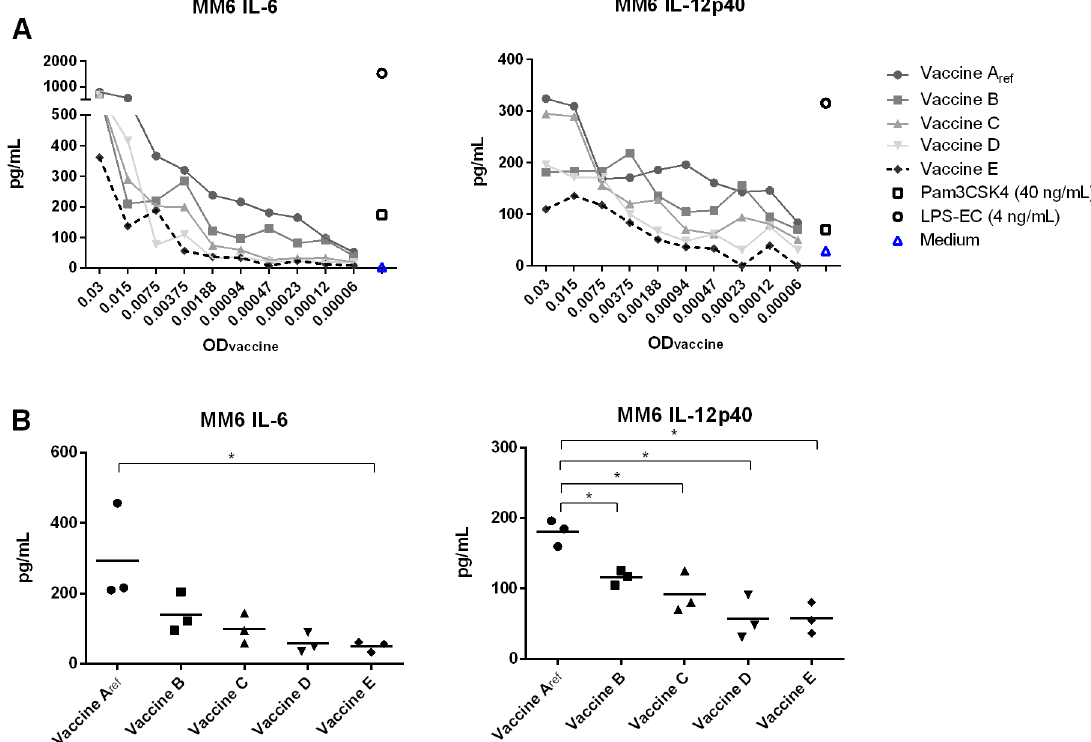
Fig 3. Secretion of IL-6 and IL-12p40 by MM6 cells stimulated with wP vaccines A ref — E. MM6 cells were stimulated overnight with vaccines A ref , B, C, D, E, LPS-EC (4 ng/mL) or PAM (40 ng/mL). Subsequently, IL-6 and IL-12p40 secretion was measured in culture supernatants. (A) Shown is the response of MM6 cells to 2-fold serial dilutions of vaccine A ref , B, C, D and E (representative responses are shown from one out of three independent experiments). (B) Response of MM6 cells to vaccines A ref , B, C, D and E at an OD 590nm of 0.00094. Each dot represents one value of three individually performed cell culture experiments. * = p <